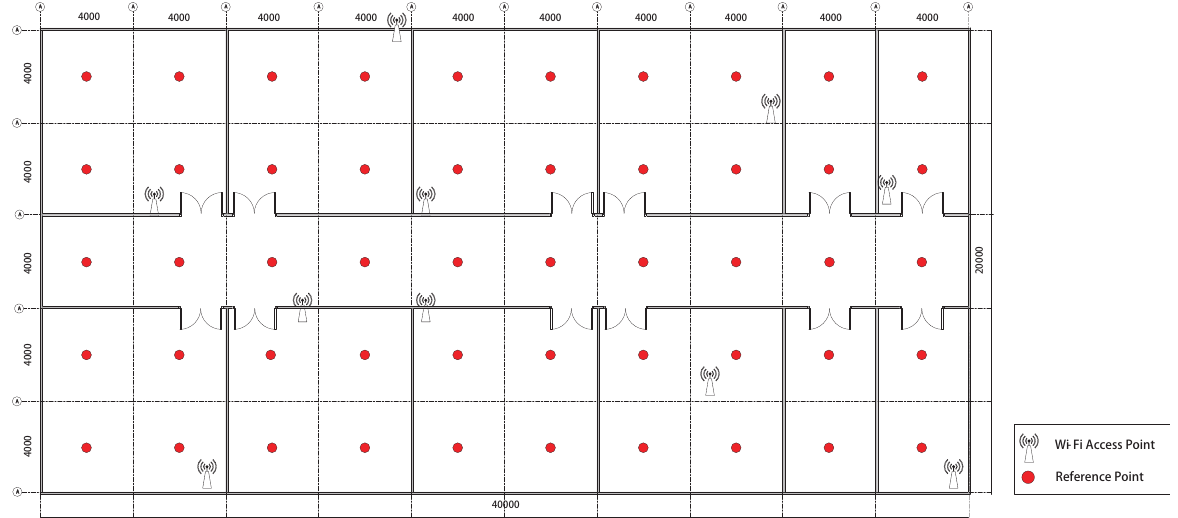
Figure 6. Setting arrangement of simulation area when the number of reference points is 50.